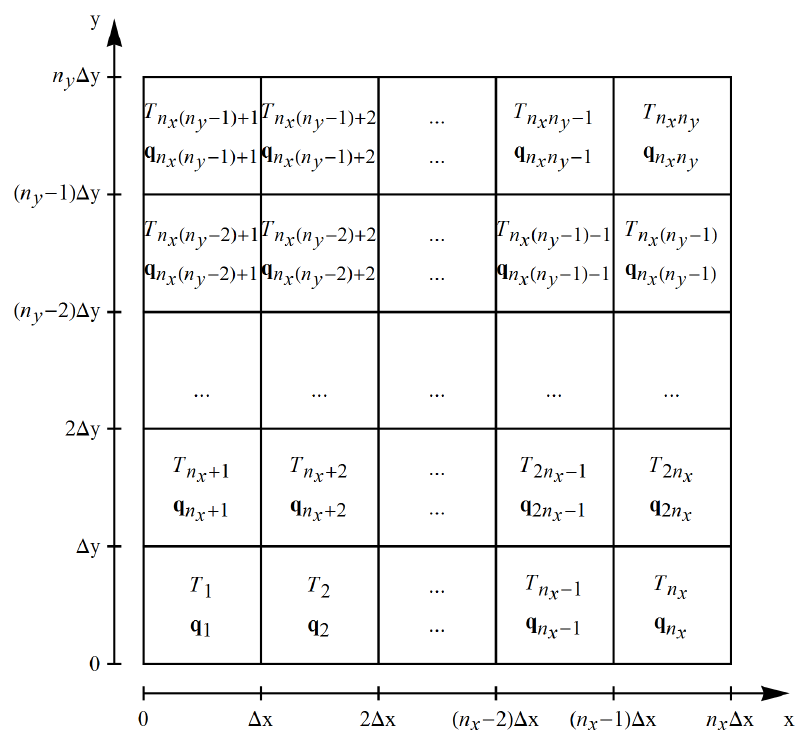
Figure 2. The graphical representation of discretization mesh and nodes’ numbering. Reprint with permission [34,39]; Copyright 2018, ŁTN